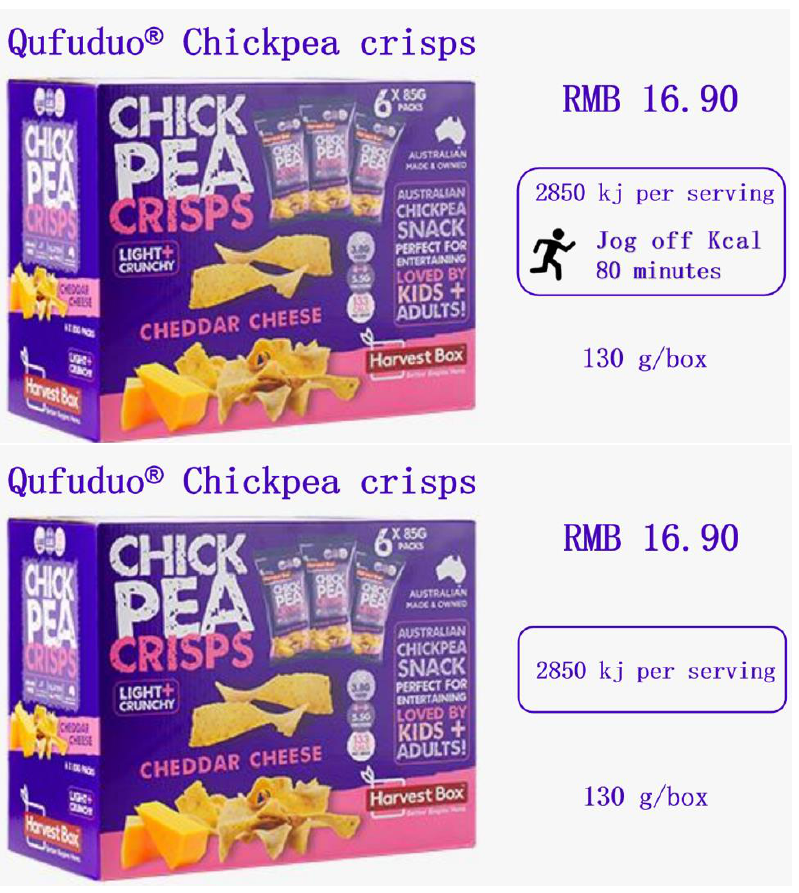
Figure 3. Stimuli of study 1.